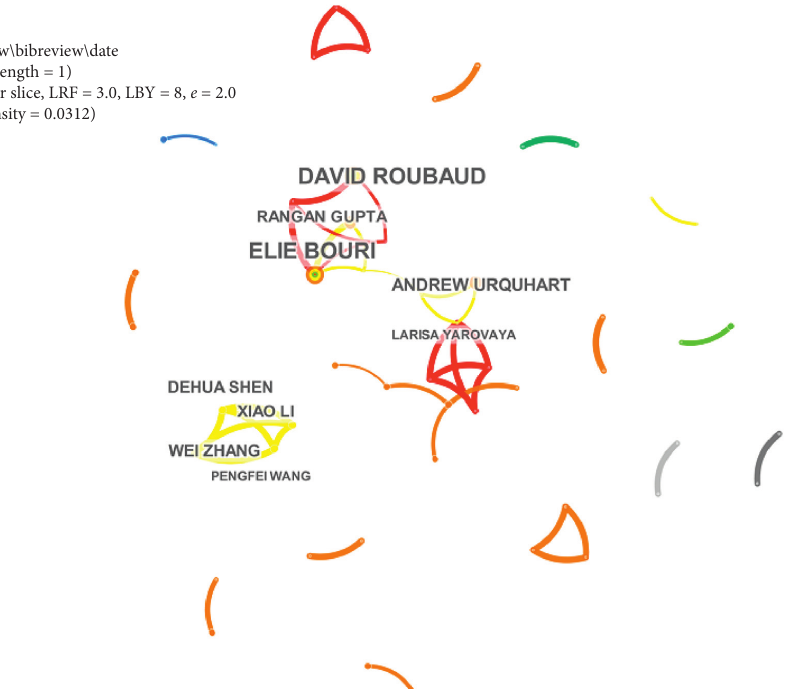
Figure 9: Collaboration of the authors in the field of DC/EP.